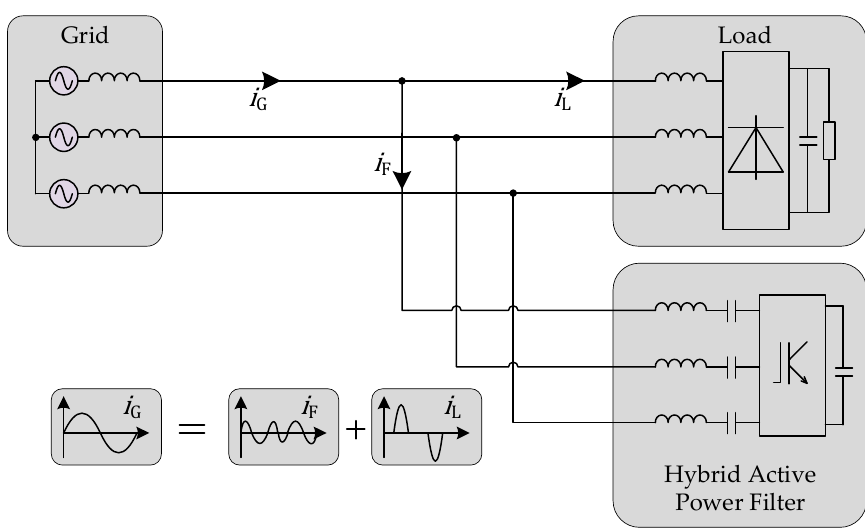
Figure 1. Connection of the proposed hybrid active power filter to the grid.